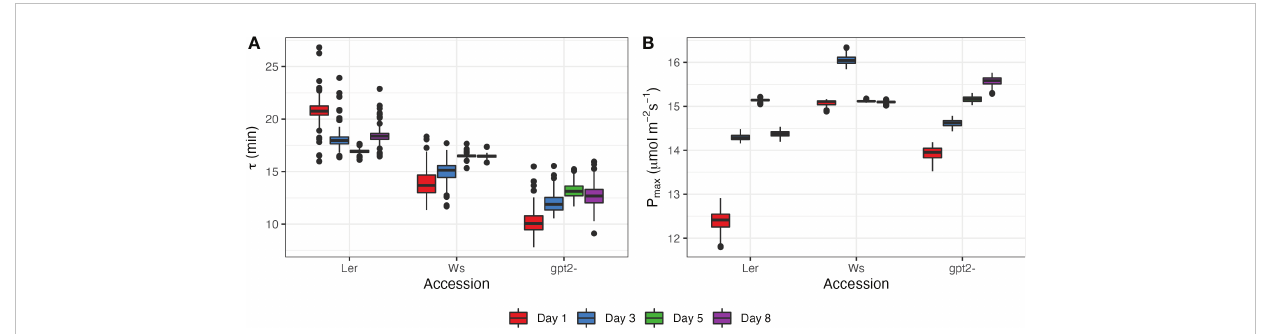
FIGURE 5 Photosynthetic response at days 1, 3, 5 and 8 after switching to FL regime for the three accessions: (A) estimated length of photosynthetic response t ; (B) estimated maximum photosynthetic capacity P max